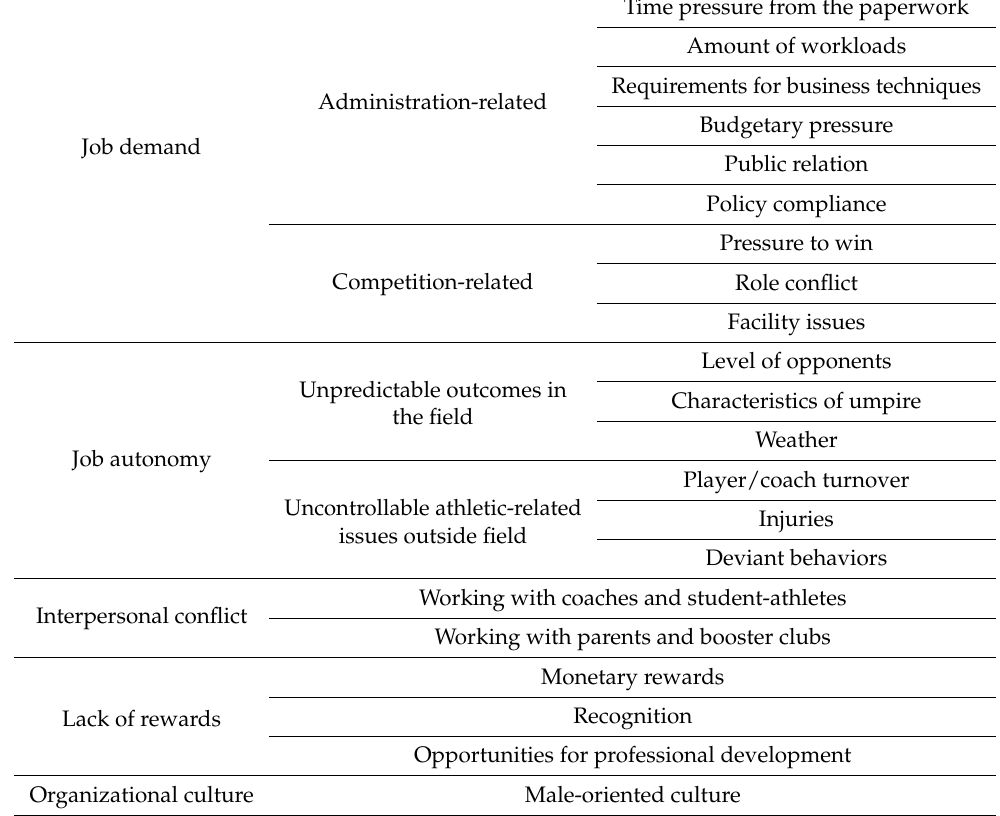
Table 1. Sources of occupational stress among sport